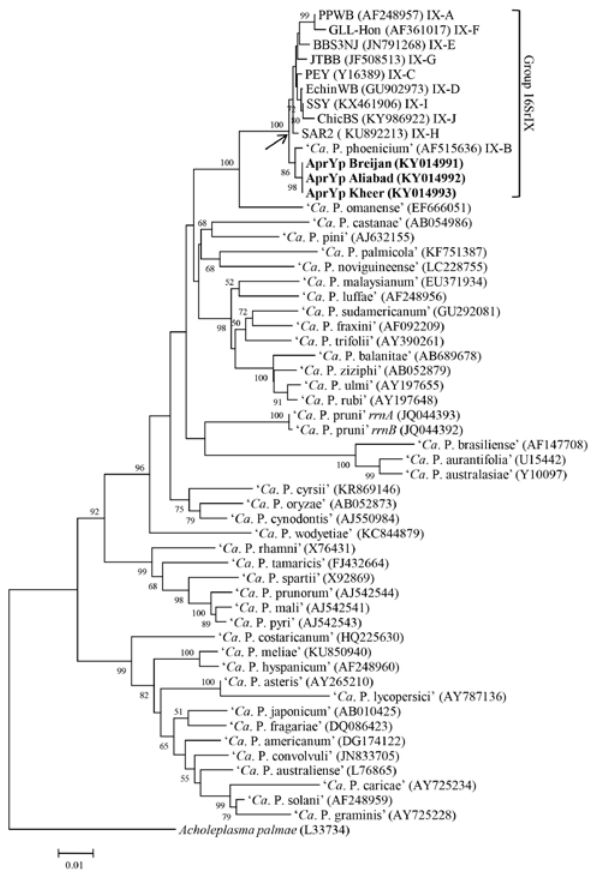
Figure 4. Phylogenetic tree inferred from 16S rDNA nucleo- tide sequences of phytoplasma strains of group 16SrIX (in - cluding AprY phytoplasmas, identified in this study) and reported ‘ Ca . Phytoplasma’ species. Minimum-Evolution analyses were carried out using the Jukes-Cantor model and bootstrap replicated 1,000 times. 16S rDNA nucleo- tide sequence of Acholeplasma palmae (Acc. No. L33734) was used for rooting the tree. GenBank accession number of each sequence is given in parentheses, and gene sequences obtained in the present study are indicated in bold font.